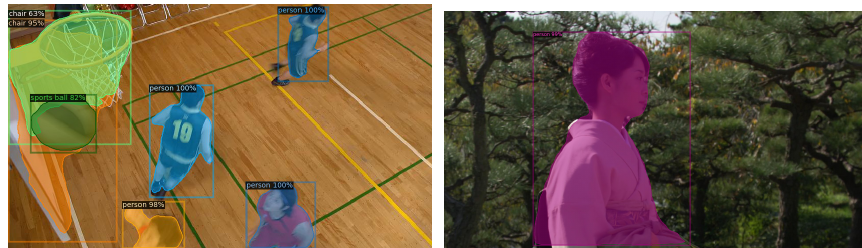
Figure 2. The VNext extraction